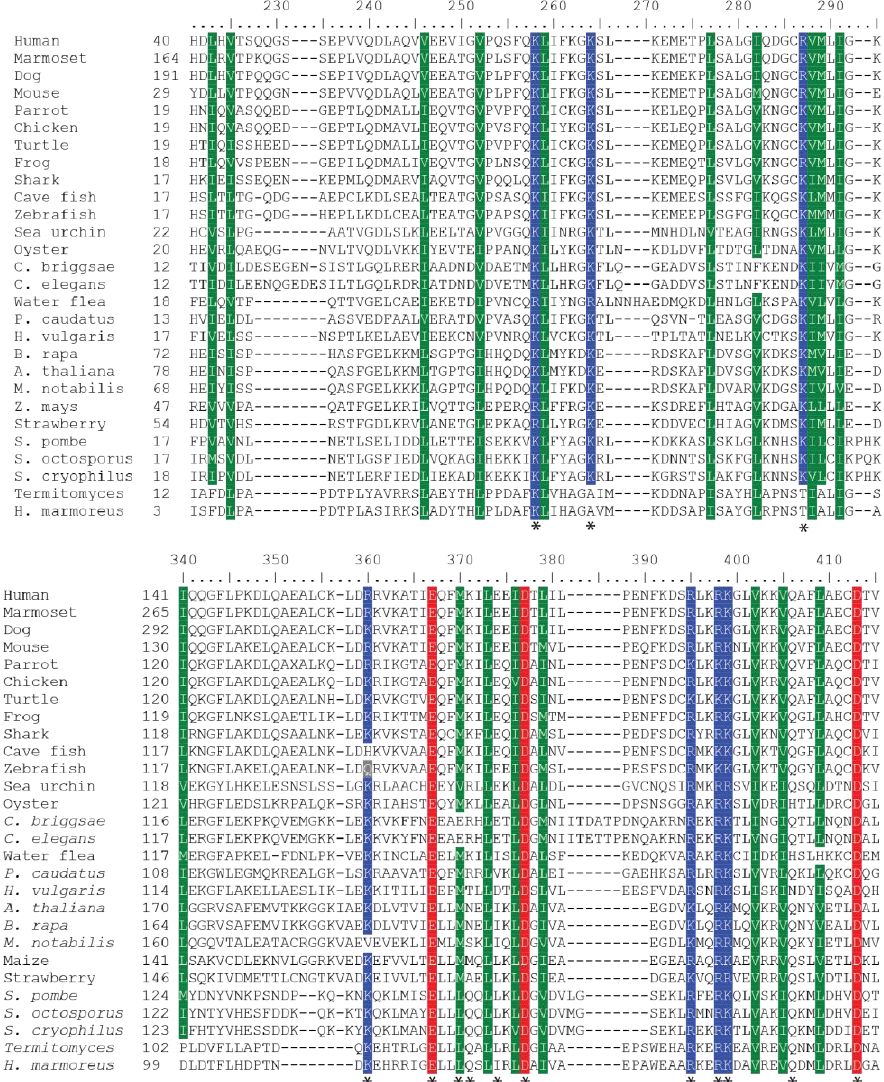
Figure 2. Divergent BAG-1 orthologs share similar functional amino acids. The multiple sequence alignment of the UBQ-like (top) and BAG domain (bottom) for 26 BAG-1 orthologs was generated using MAFFT version 7, with the E-INS-i strategy [37]. Residues labeled with an asterisk represent known functional amino acids present within the human BAG-1 [25] .